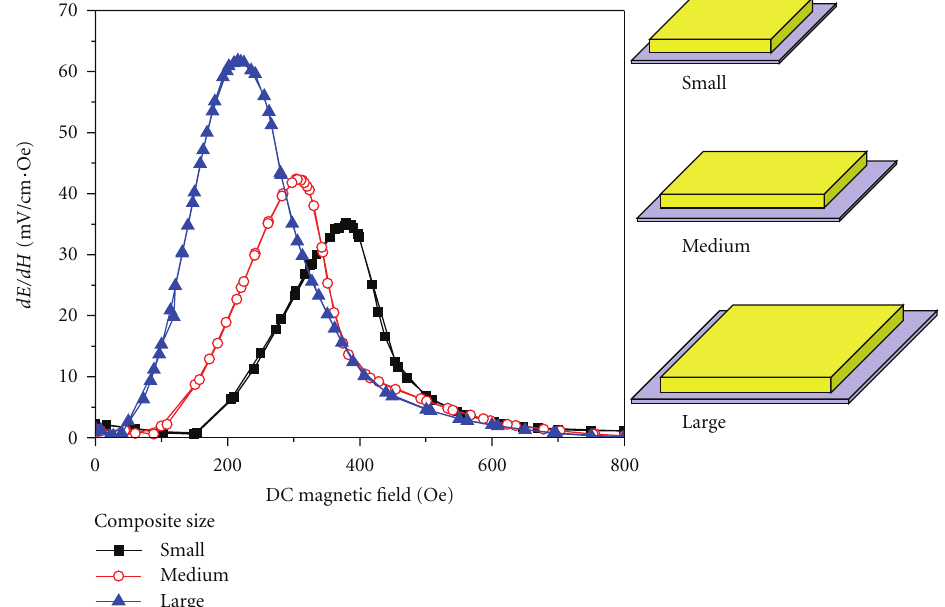
Figure 5: ME coe ffi cient variation as a function of DC magnetic field for various dimensions. 20 layers of Metglas were attached on all PZNT plates. All ME measurements were conducted under H ac = 1Oe at 1 kHz